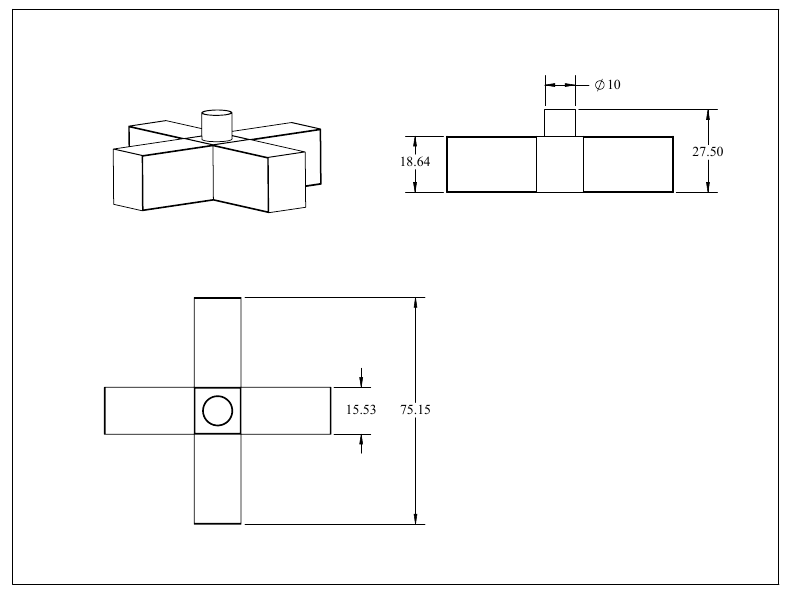
Figure 20. Drawing of the